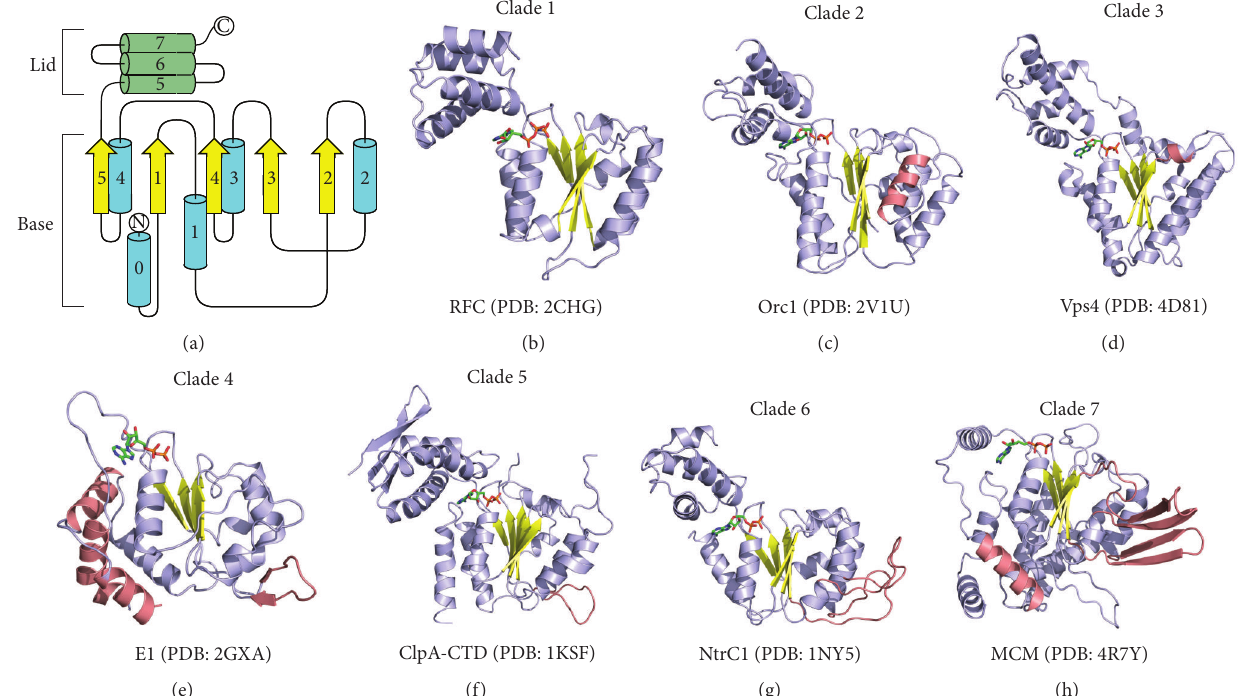
Figure 2: Clade-specific features of the AAA+ domain. (a) The simplest AAA+ domain is characterized by an 𝛼 - 𝛽 - 𝛼 topology with a C- terminal 𝛼 -helical lid domain. Helices and strands within the base domain are shown as blue cylinders and yellow arrows, respectively, and lid domain helices are represented by green cylinders. (b–h) A crystal structure of a characteristic member of each clade is shown in cartoon representation with helices and strands colored as blue and yellow, respectively. The insertions that distinguish each clade are highlighted in salmon. Each structure contains a bound nucleotide molecule that is shown in stick. The protein topology cartoon in (a) was prepared using the TopDraw software package [42]. All structure representations in the figure were prepared with the Pymol software package [43] and PDB accession codes 2CHG [44] (b), 2V1U [45] (c), 4D81 [46] (d), 2GXA [40] (e), 1KSF [47] (f), 1NY5 [48] (g), and 4R7Y [41]